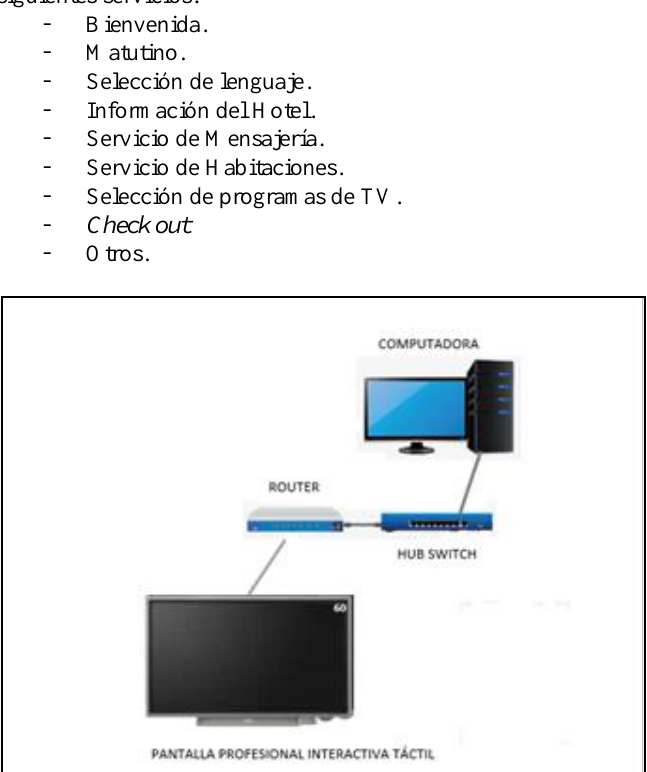
Figura 8: Pantalla profesional conectada a PC. Fuente: Los autores,